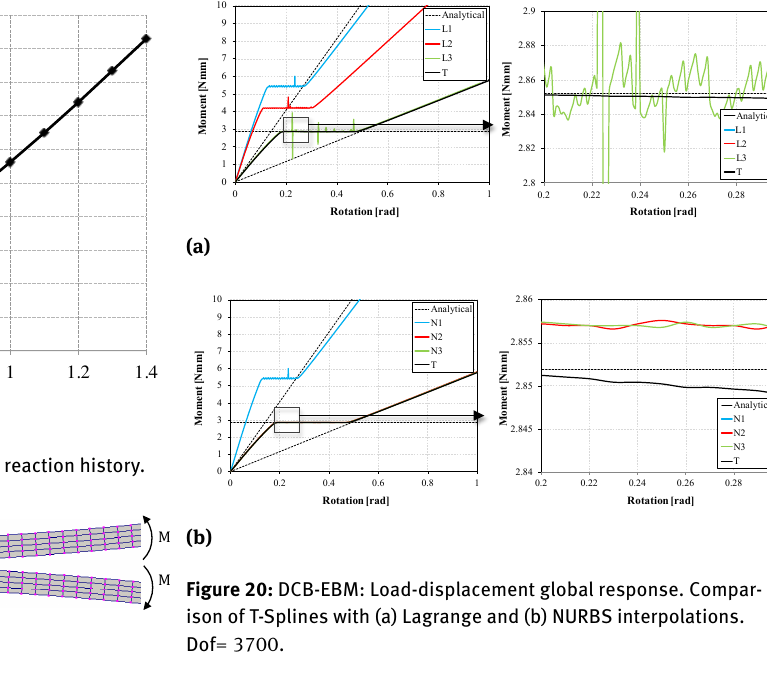
Figure 20: DCB-EBM: Load-displacement global response. Compar- ison of T-Splines with (a) Lagrange and (b) NURBS interpolations. Dof = 3700